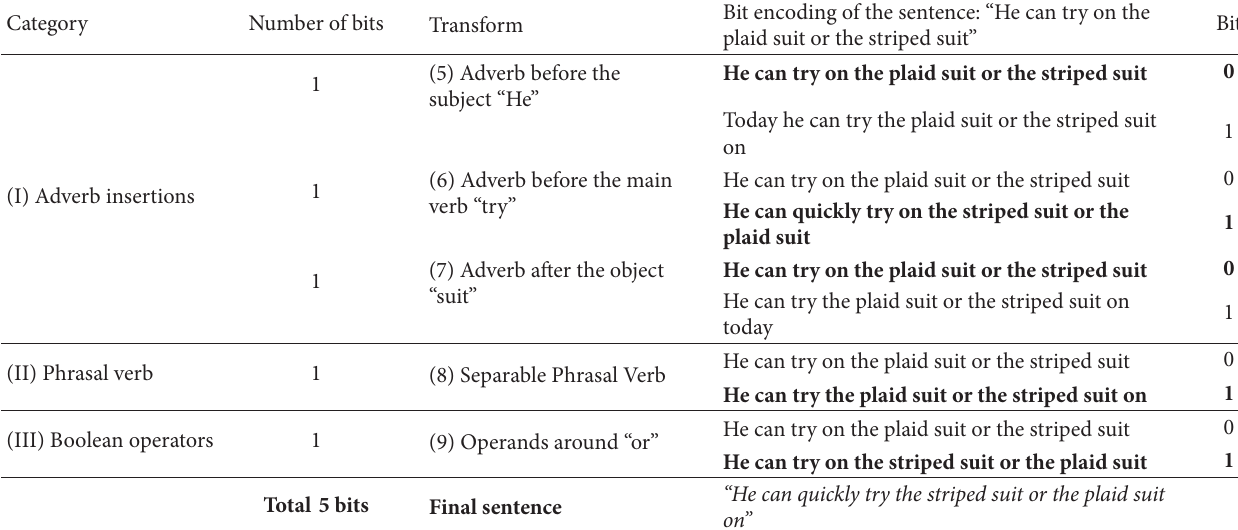
Table 10: Example of the transformation process applied to the sentence “He can try on the plaid suit or the striped suit.” The sentence was transformed to “He can quickly try the striped or plaid suit on” which embeds the 5 bits of a secret message: 0 1 0 1 1.